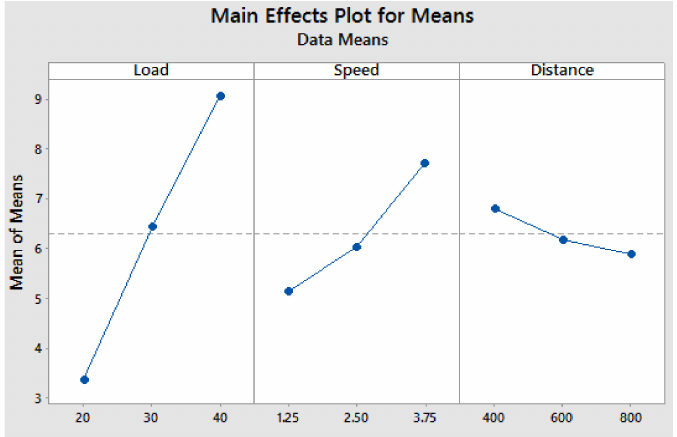
Figure 11. Mean effect plot for sample